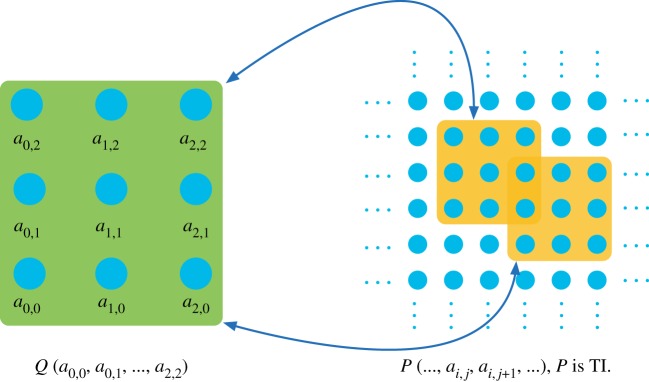
The 2D TI marginal problem. In the example, there is only one region, K = 3 × 3. A probability distribution Q3×3 for the nine variables {ai,j: i, j = 0, 1, 2} is given (the green square), and the question is whether there exists a 2D TI system with a marginal probability distribution P3×3 (the yellow squares) equal to Q3×3. (Online version in colour.)